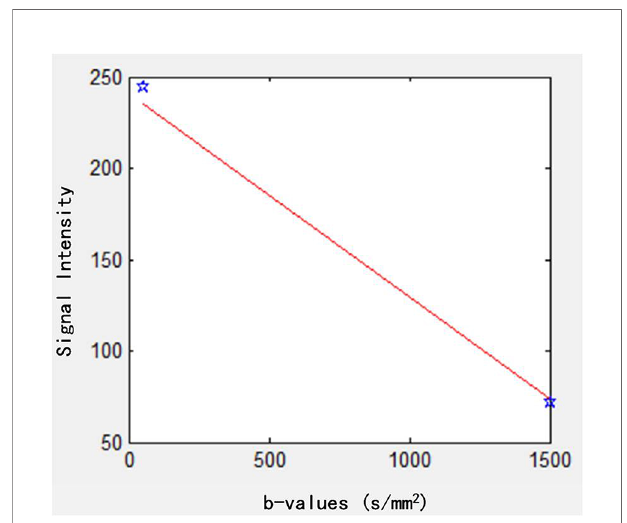
FIGURE 3 | Fitting curve of MEM. MEM, monoexponential